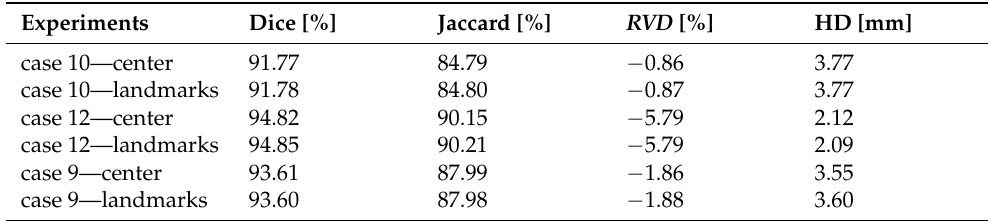
Table 4. Registration results in both configurations. The first utilizes the center of the images as the initializer, and the second utilizes a set of landmarks as the